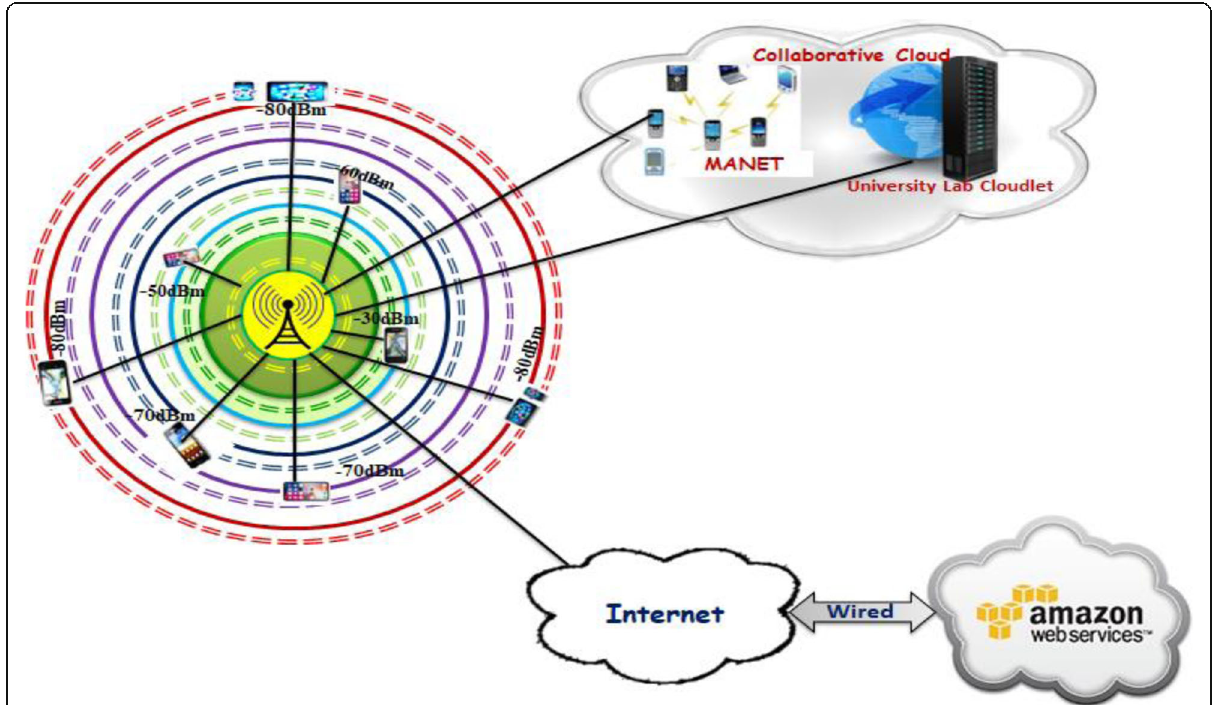
Fig. 4 mRARSA architecture. The proposed architecture considers radio frequency barriers. The component signal strength analyzer analyzes the signal strength of participating nodes during application task execution at a particular frequency ( − 30 dBm to − 80 dBm). If the requesting device encounters barrier (i.e. signal strength is low), then the task execution possibly switches to other cloud resources (collaborative-cloud or cloud) or to other P2P nodes of higher signal strength depending upon the algorithm